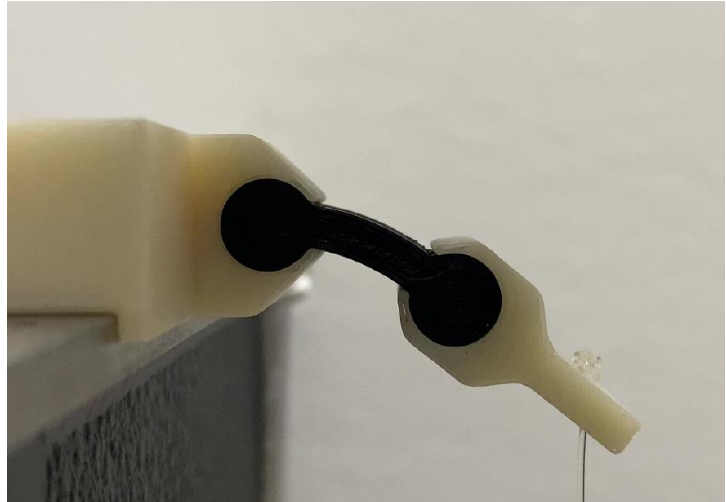
Figure 2 . A loaded specimen between